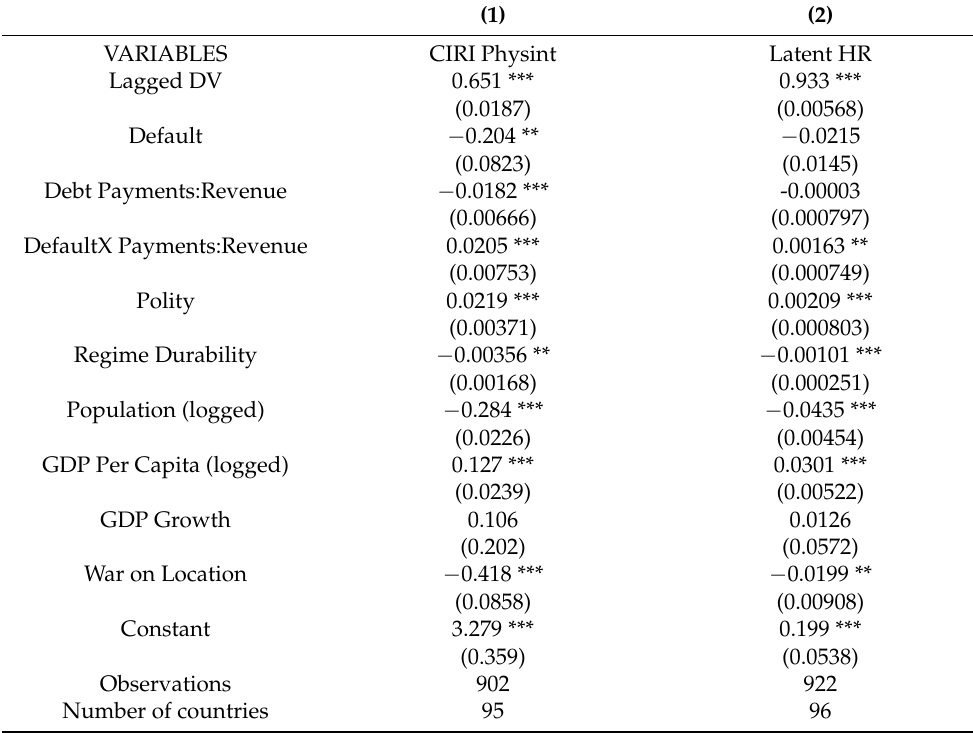
Table 2. Default x Debt to Revenue and Physical Integrity